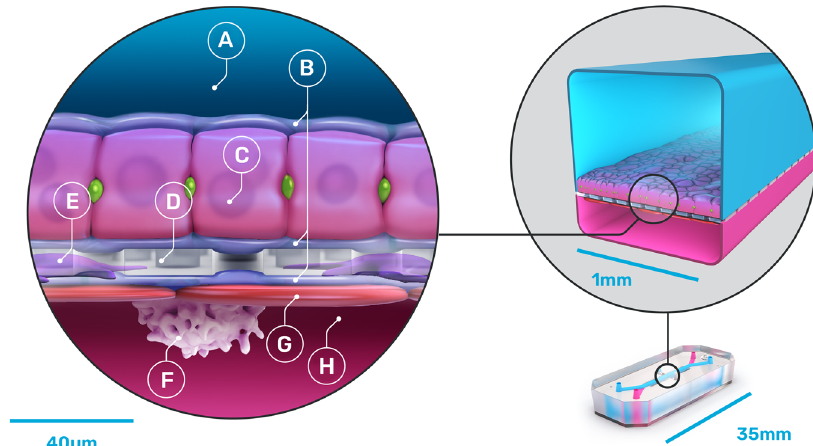
Fig. 1 Schematic of the Emulate Liver-Chip. This diagram shows primary human hepatocytes (C) that are sandwiched within an extracellular matrix (B) on a porous membrane (D) within the upper parenchymal channel (A), while human liver sinusoidal endothelial cells (G), Kupffer cells (F), and stellate cells (E) are cultured on the opposite side of the membrane in the lower vascular channel